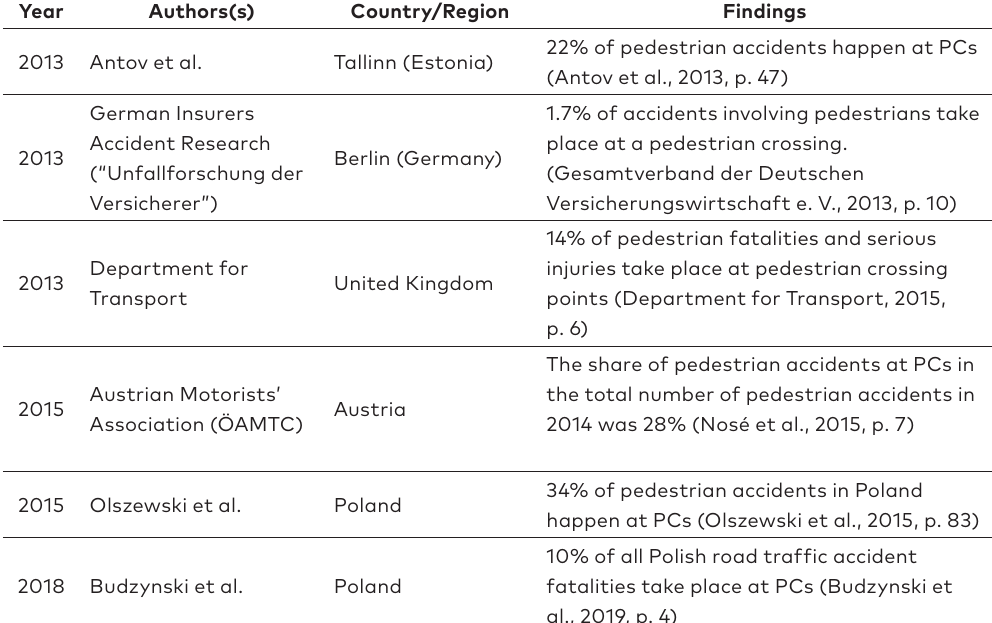
Table 1. Comparison of